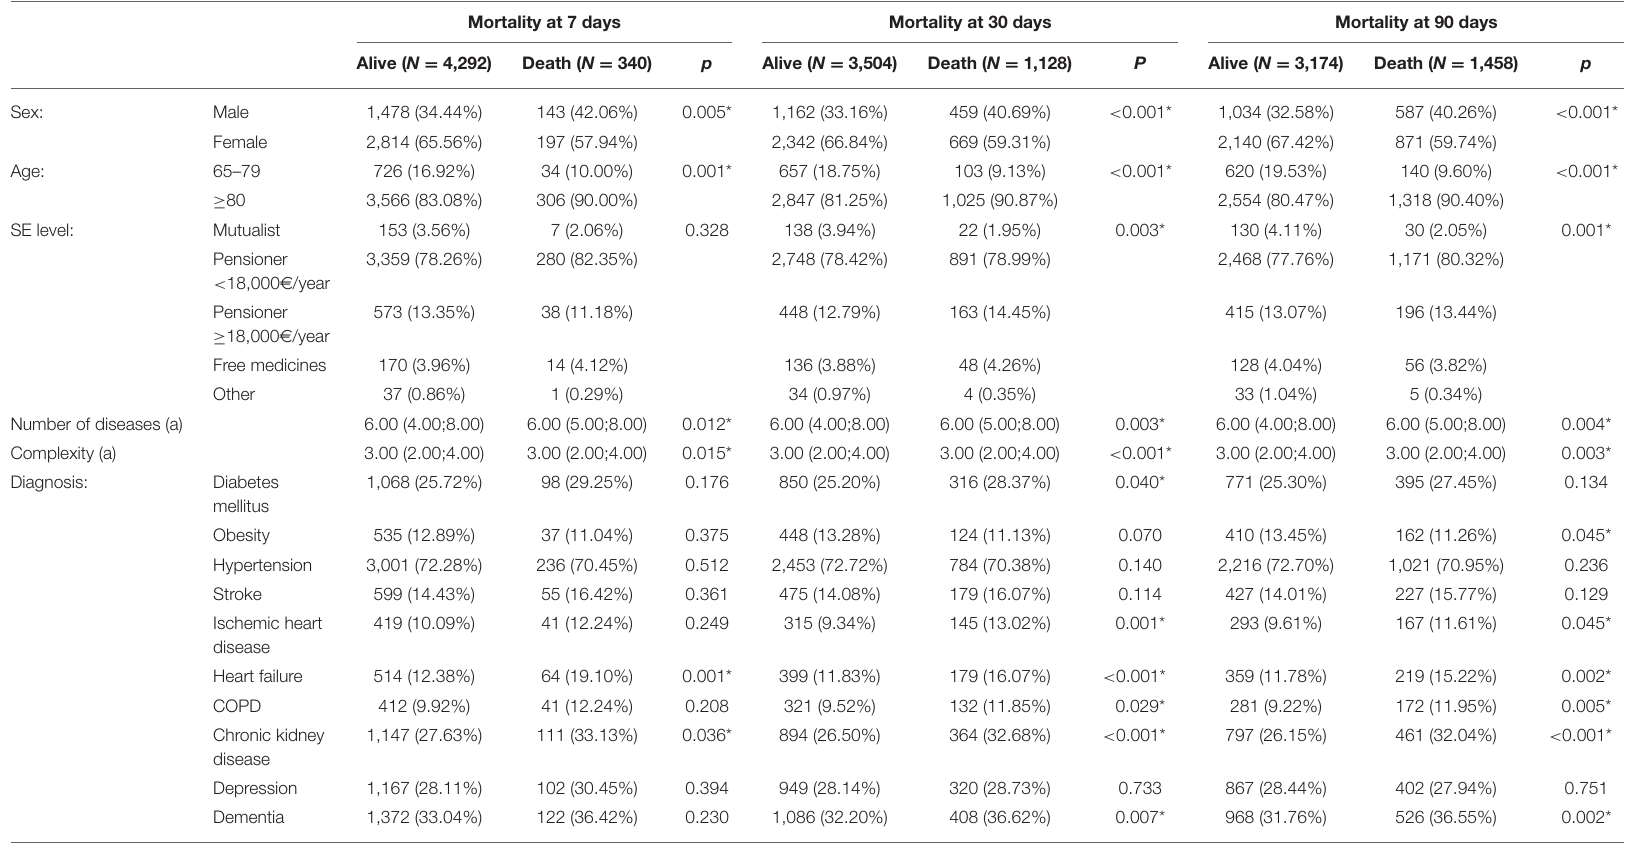
TABLE 2 | Mortality in COVID-19 confirmed institutionalized patients over 64 years of age. Mortality at 7 days Mortality at 30 days Mortality at 90